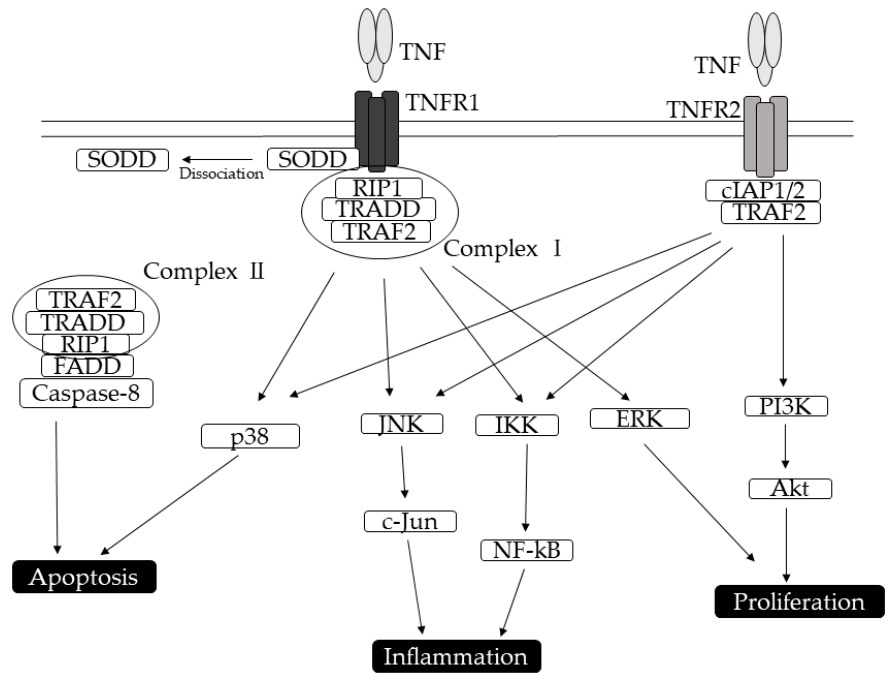
Figure 1. Pathways induced by tumor necrosis factor receptors (TNFRs). TNFR1 and TNFR2 activate shared and divergent signaling pathways and downstream cellular responses that lead to apoptosis, proliferation, and inflammatory mediators. The initial step in TNF-TNFR1 signaling involves the release of the inhibitory protein silencer of death domains (SODD) from TNFR1 intracellular domain. Subsequently, TNFR1 recruits distinct adaptor molecules TNFR-associated death domain (TRADD), TNFR-associated factor 2 (TRAF-2), receptor-interacting protein (RIP) at the intracellular death domain, thereby activating NF- κ B-signaling, MAPK / c-Jun-signaling, and caspase-signaling. After binding of TNF α , TNFR2 intracellular domains recruit existing cytoplasmic TRAF2–cIAP1–cIAP2 complexes. TNFR2 activation leads to PI3K / Akt and NF- κ B activation.